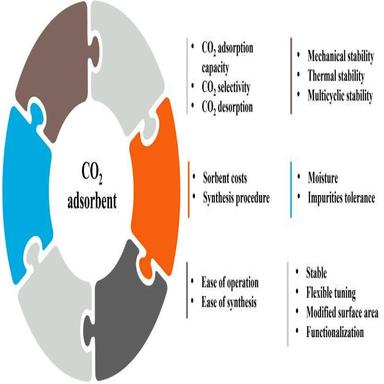
The schematic representation of properties of the required adsorbent for CO2 adsorption.